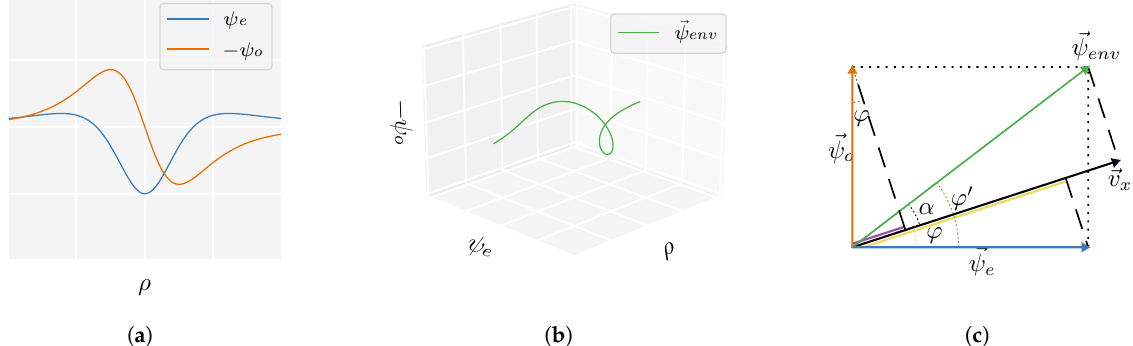
Figure 4. Graphical illustration of the movement direction estimation from the measured velocity and the source’s position p = (cid:104) b , d (cid:105) . ( a ) A view of ψ e ( ρ ) and ψ o ( ρ ) along the sensor array. ( b ) The values of the wavelets can be interpreted as vectors ( (cid:126) ψ e and (cid:126) ψ o ) in a 3D ψ e – ψ e – ρ space. Their vector combination (cid:126) ψ env = (cid:126) ψ e + (cid:126) ψ o is a fixed 3D wavelet structure that can be constructed solely from the source’s previously determined position p . This vector (cid:126) ψ env has a magnitude ψ env = and angle ϕ (cid:48) = atan ψ o / ψ e . The measured velocities—which are linear combinations of ψ e and ψ o —can be viewed as a 2D projection of this 3D wavelet. For instance, a projection on the ρ – ψ e plane (bottom plane) yields ψ e for ϕ = 0 rad. For a general angle ϕ , the measured velocity profile is a projection on a plane through the ρ axis subtending an angle ϕ with the ρ – ψ e plane. ( c ) Diagram illustrating the geometric relation between a measured v x , the angles α and ϕ (cid:48) which are constrained via ψ env , and the movement orientation ϕ . We show a slice of (cid:126) ψ env (green) in the ψ e – ψ o plane for a fixed value of ρ . The velocity value at this fixed ρ is a vector (cid:126) v x (black) in this space. It has a length v x ∝ ψ e cos ϕ + ψ o sin ϕ and has angle ϕ . The contributions of (cid:126) ψ e (blue) and (cid:126) ψ o (orange) to v x are shown in yellow and purple. The angle ϕ (cid:48) of (cid:126) ψ env can be computed directly from an estimated source position. Given that the difference between ϕ and ϕ (cid:48) is α = acos v x / ψ env , we can compute an estimate of ϕ at every sensor using only measured velocity values and a position